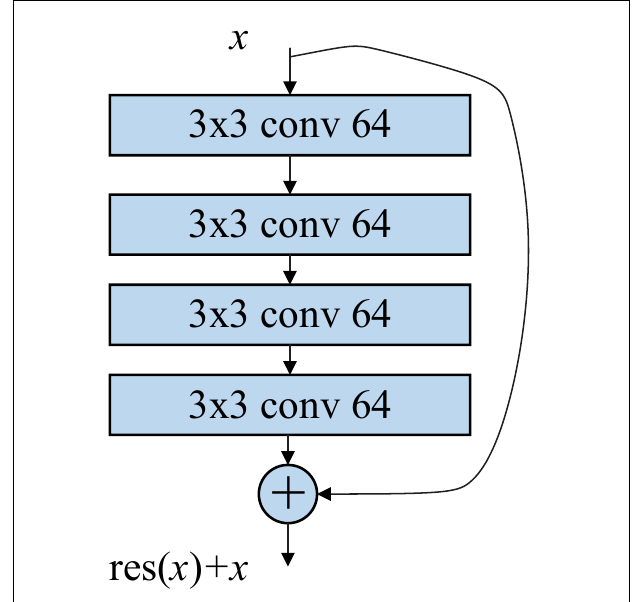
FIGURE 3 | A shortcut in a CNN.